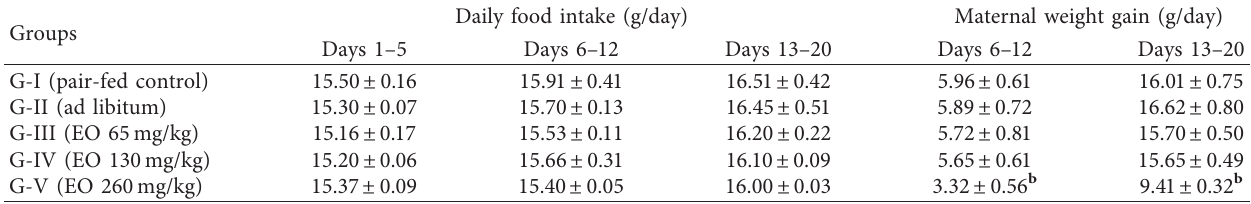
Table 4: Daily food intakes and maternal weight gains of animals in the day 20 administration of essential oil of Thymus schimperi .